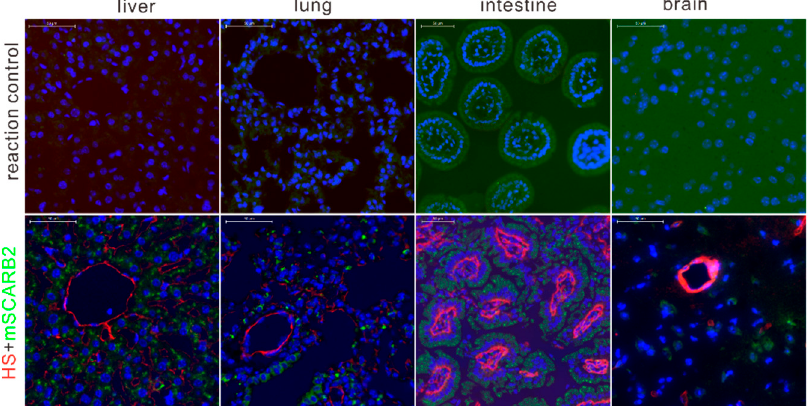
Figure 8. Expression of HS and SCARB2 proteins in different tissues of mouse. The liver, lung, intestine, and brain tissues were harvested from BALB/c mice. Sections incubated anti-HS and anti-SCARB2 antibody, or not incubated with primary antibodies (reaction control), were stained with fluorescent secondary antibodies to detect the expression of both receptors. Red: HS signal. Green: SCARB2 signal. Cell nuclei were stained with DAPI (blue). Scale bar: 50 μ m.